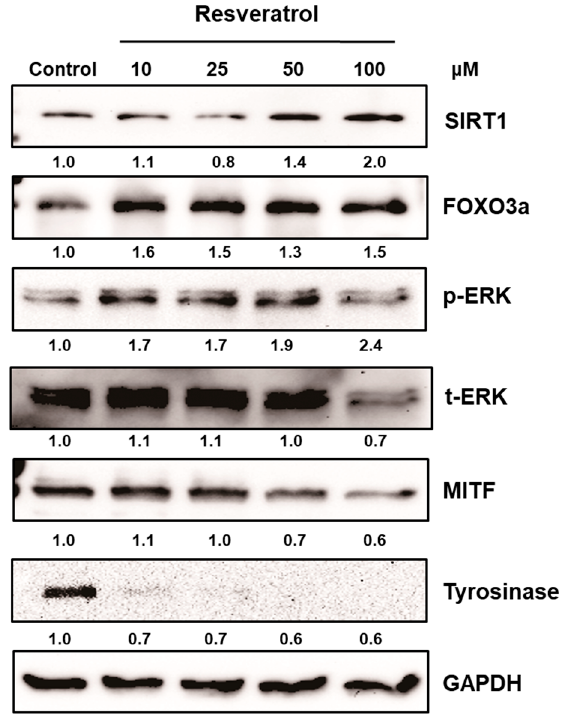
Figure 3. Normal human melanocytes were treated with 10 to 100 μ M of resveratrol for 24 h. Then, the levels of ERK, MITF, tyrosinase, SIRT1, and FOXO3a were investigated.